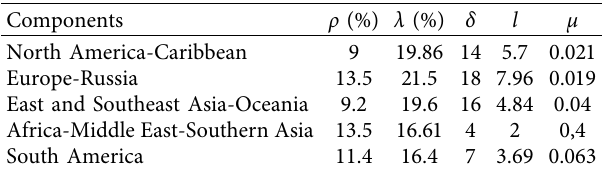
Figure 4: Te fgure at the left represents the fraction of nodes in the LCC of the large local and global components as a function of the fraction of removed nodes under a strength attack on the world air transportation network. We also represent the LCC of the world air transportation network in this situation. Te Europe-Russia component and the global component are less sensitive to the attack. Te fgure at the right shows the weighted efciency of the large local and global components as a function of the fraction of removed nodes under a strength attack on the world air transportation network. We also represent the weighted efciency of the world air transportation network in this situation. Efciency decreases at a high rate as the fraction of top strength nodes removed increases. Furthermore, the North America- Caribbean and Africa-Middle East-Southern Asia components appear to be the most vulnerable. Table 2: Basic topological properties of the fve local components isolated by the strength attack. λ is the size of the isolated com- ponent. ρ is the fraction of top strength nodes removed from the world air transportation network to isolate the component. δ is the diameter. l is the average shortest path length. μ is the